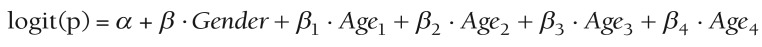
Geographic distribution of the included studies. The classification of East, Central and West was based on the 31 provinces’ geography and economic development [38,39]. The most developed region (East) includes Beijing, Tianjin, Hebei, Liaoning, Shanghai, Jiangsu, Zhejiang, Fujian, Shandong, Guangdong and Hainan; The least developed region (West) includes Inner Mongolia, Chongqing, Guangxi, Sichuan, Guizhou, Yunnan, Tibet, Shaanxi, Gansu, Qinghai, Ningxia, and Xinjiang; The Central region includes Shanxi, Jilin, Heilongjiang, Anhui, Jiangxi, Henan, Hubei and Hunan.